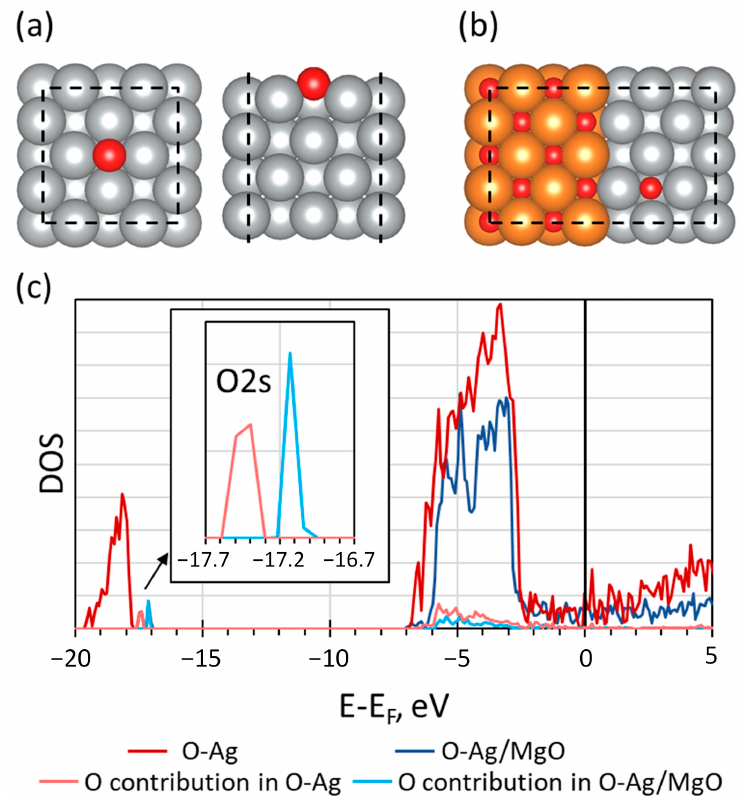
Figure 7. Atomic model of oxygen on the Ag surface ( a ) and Ag/MgO interface ( b ). O, Ag, and Mg are marked in red, gray, and orange, respectively. The unit cell is shown with dashed lines. Density of electronic states of oxygen adsorbed on Ag surface (red color) and Ag/MgO interface (blue color) ( c ). The partial density of oxygen electronic states is represented by pink and cyan colors for the first and second cases, respectively. The inset shows the enlarged region of O2s levels. The Fermi level is not shown.